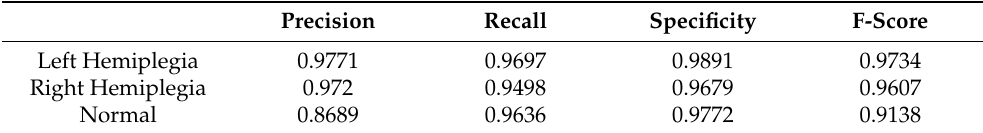
Table 3. Performance